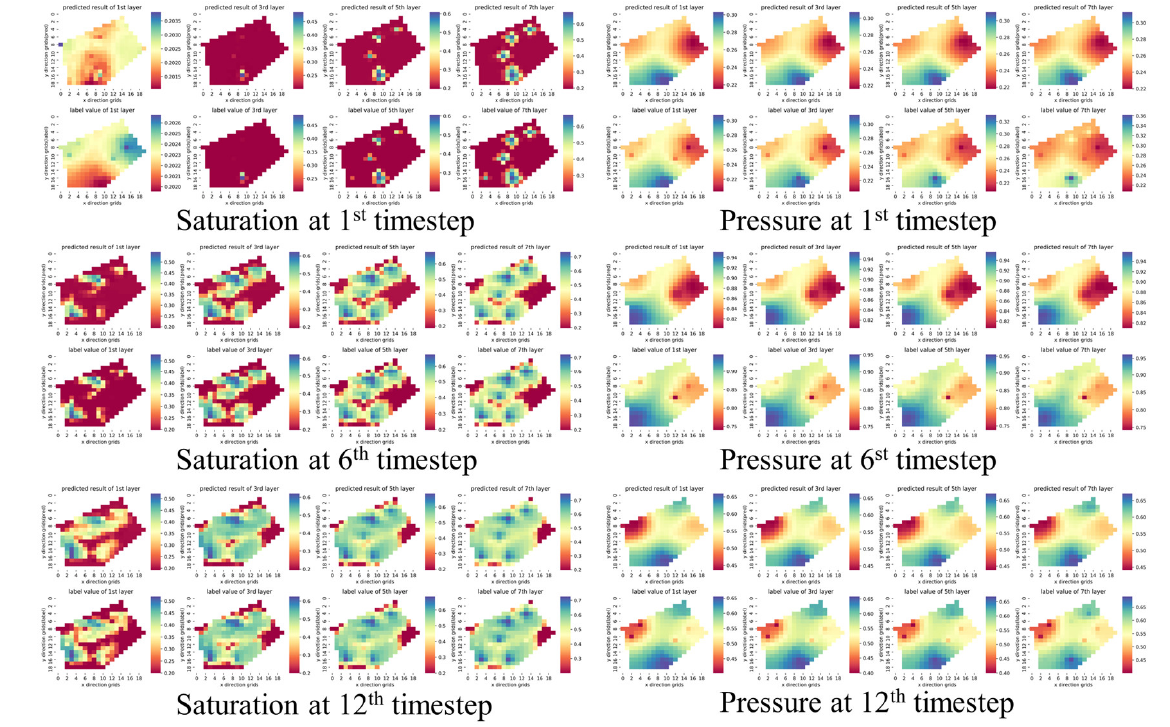
Figure 15. The comparison of two fields by our method (predicted) and simulator (labels) for pentagon-shaped reservoir Case 1.